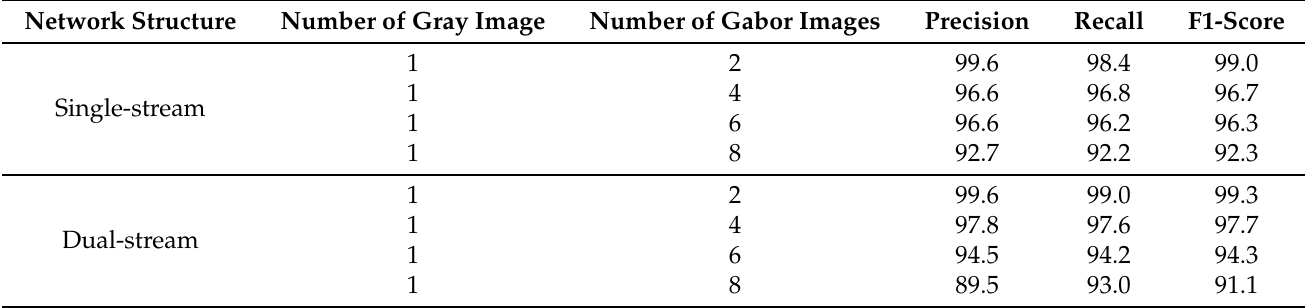
Table 9. Performance according to the number of gabor images on compact camera module dataset. Network